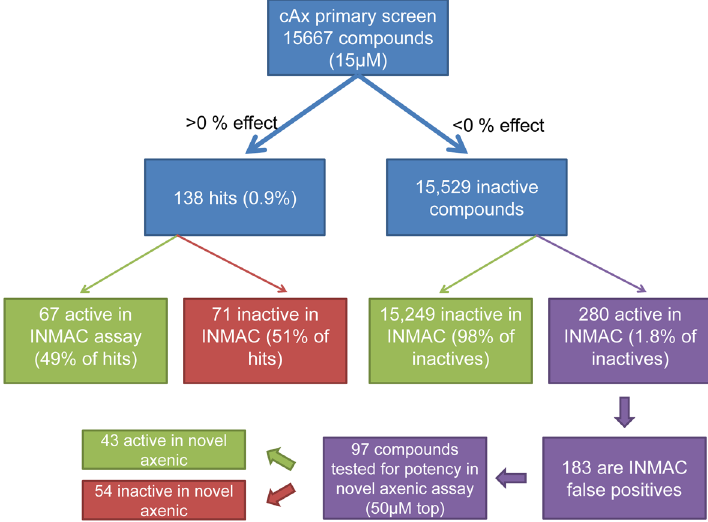
Fig 2. Library screen with novel axenic assay, comparison with intracellular results. 15,667 compounds were screened in the novel axenic assay at 15 μ M. Comparison with the intracellular assay shows that 67 of the hits are also active in the intracellular assay whereas 71 of the hits are not. 280 novel axenic assay inactive compounds were hits in the intracellular assay, 170 of these compounds showed toxicity in the intracellular assay (in single point mode, at 50 μ M, or less than 3-fold selectivity window in potency assay) and are therefore considered false positives in the intracellular assay. Potencies were determined for 110 non-toxic compounds in the novel axenic and intracellular assays. 13 compounds were inactive in the intracellular assay and are added to the false positive count (13 + 170 = 183). 97 compounds had confirmed activity in the intracellular assay; 42 of these compounds showed activity in the novel axenic assay, while 54 did not. (INMAC = intracellular assay). Hit criteria as described in Table A in S1 Text.